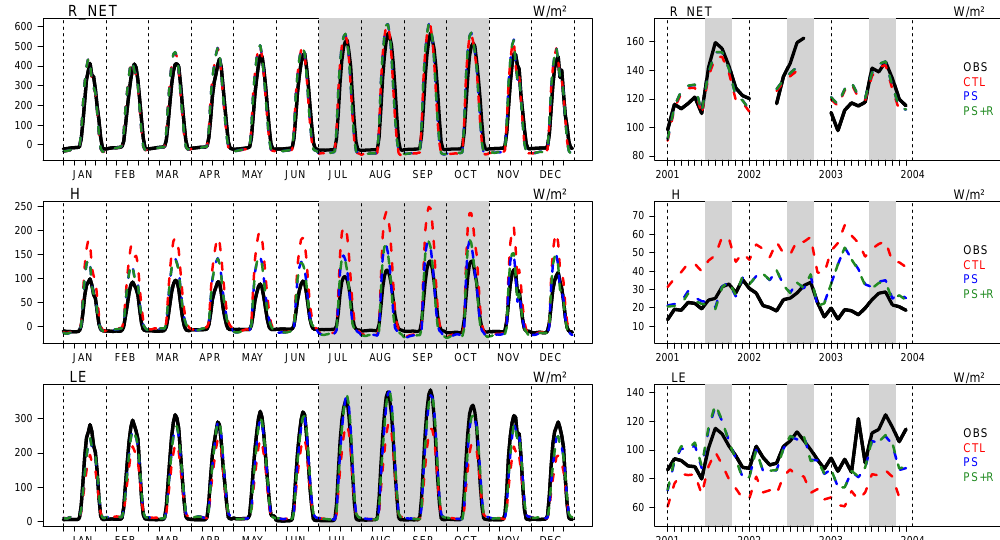
Figure 4. Observed and simulated net radiation ( R Net ), sensible heat ( H ) and latent heat (LE) at K83. Left panels show the diurnal cycle for each month averaged over 3 years (2001–2003); and right panels, monthly mean time series for 2001–2003. Gray shaded areas indicate dry seasons (defined as periods with precipitation less than 100mmmonth − 1